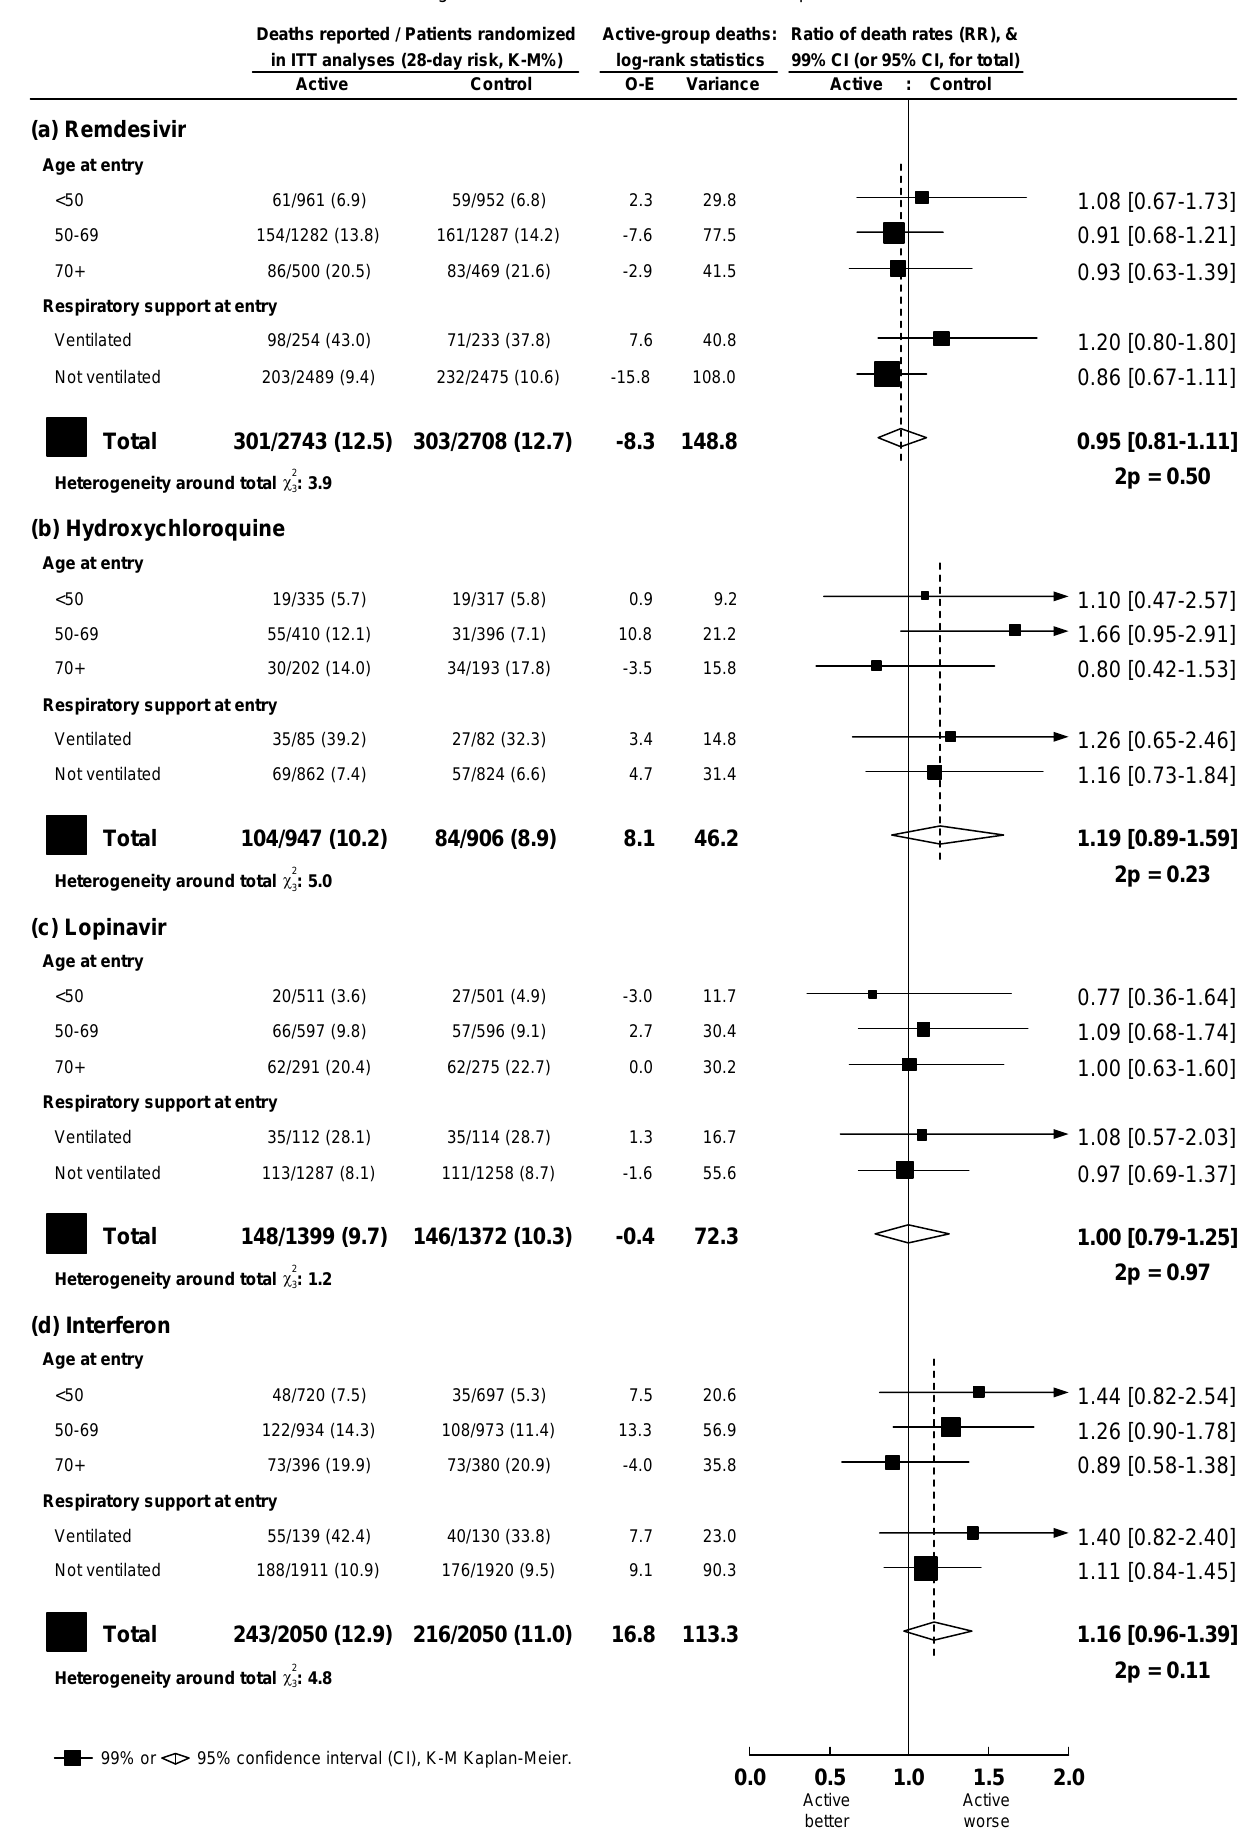
Figure 3. Rate ratios of any death, stratified by age and respiratory support at entry, (a) Remdesivir, (b) Hydroxychloroquine, (c) Lopinavir, (d) Interferon, each vs its